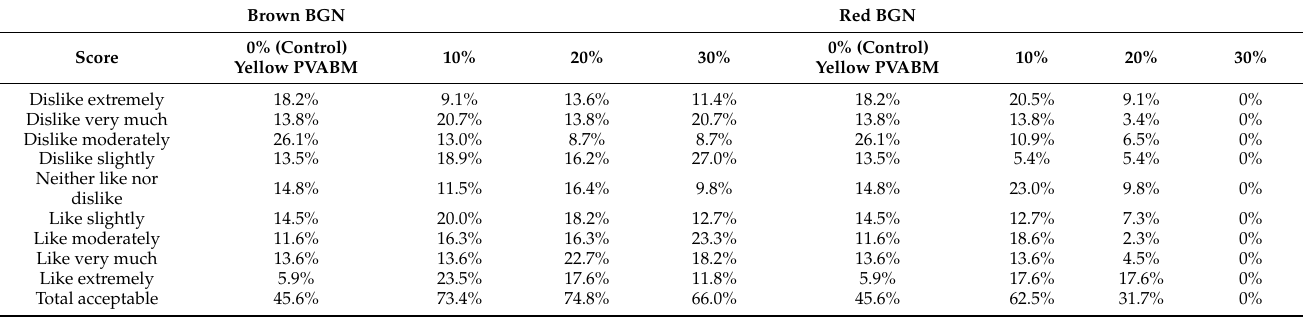
Table 9. The percentage of panelists who rated the overall acceptability of composite complementary instant porridge samples containing different concentrations of either red BGN or brown BGN and yellow PVABM